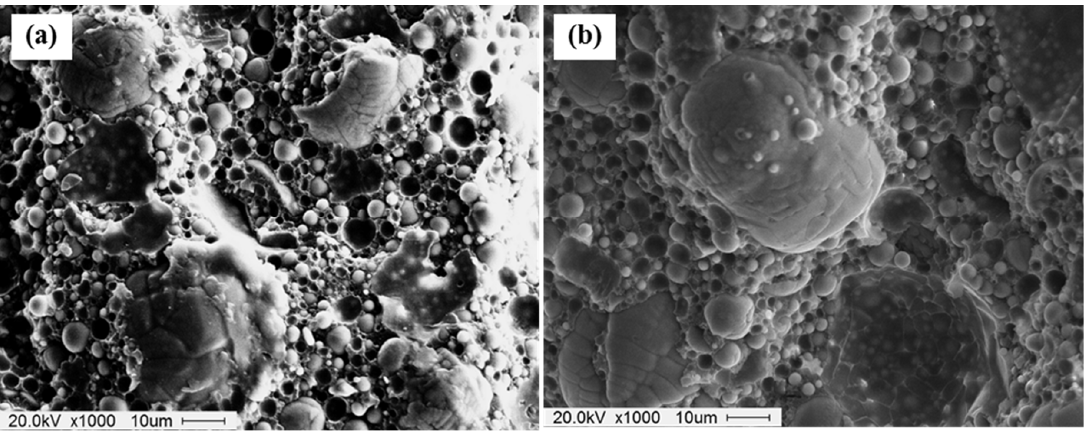
Figure 5. SEM images of Al 2 O 3 /EP without BN: ( a ) BN0DAB1800 and ( b ) BN0DAB2200.